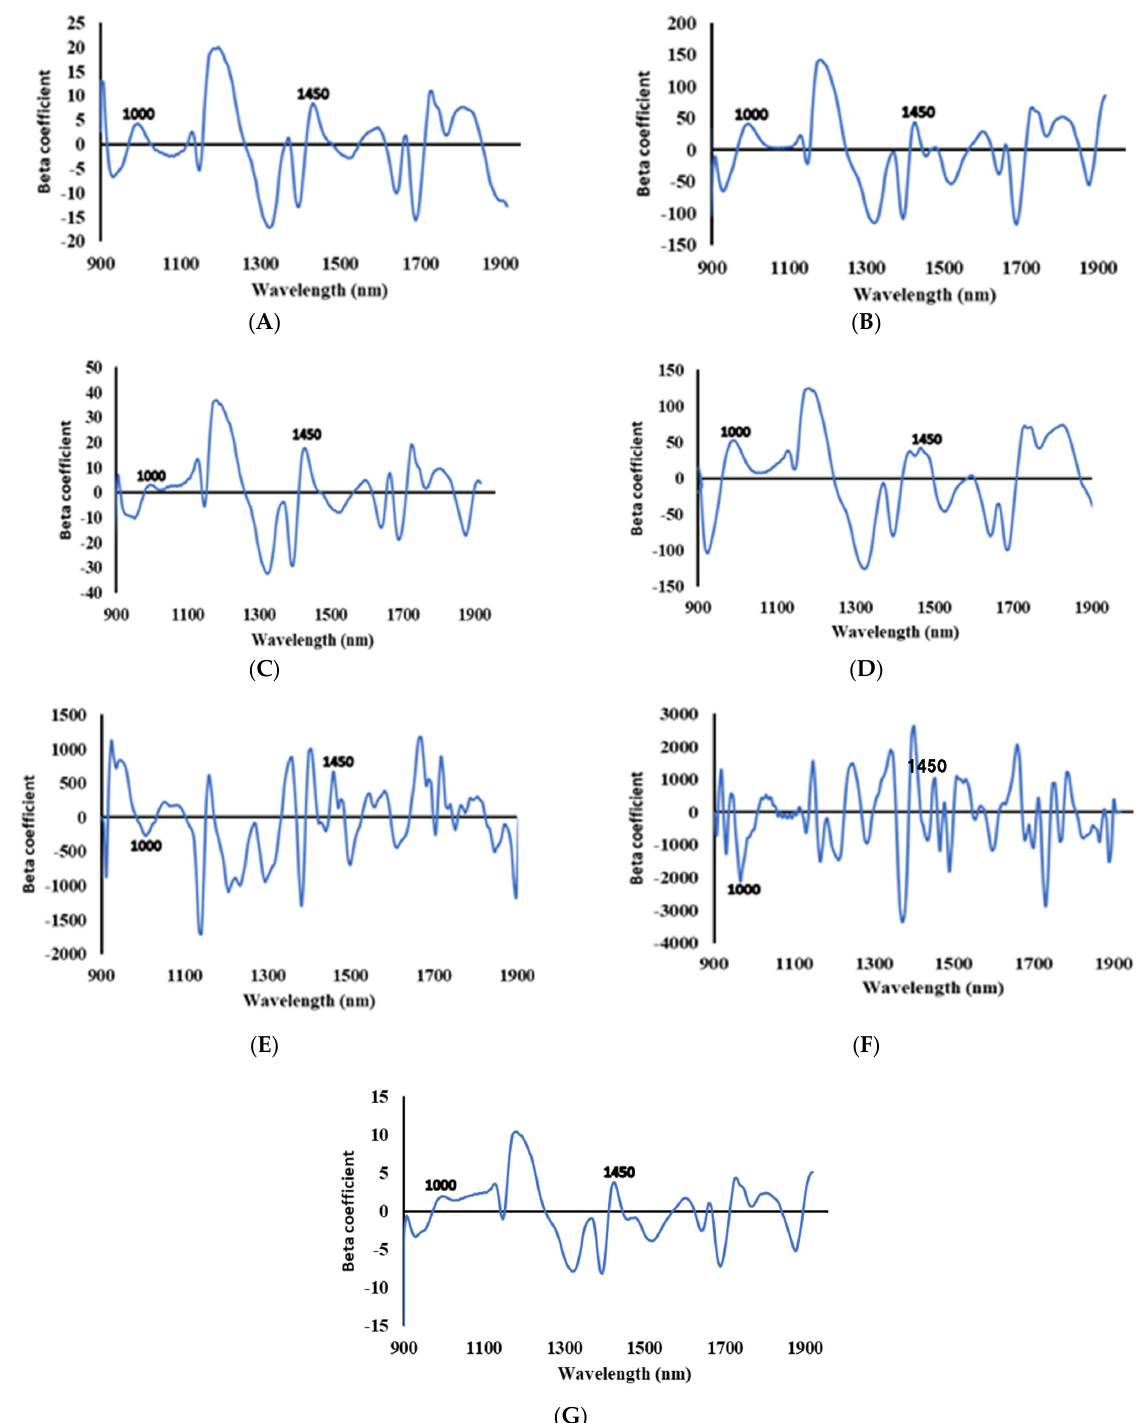
Figure 7. Beta coefficient plot: mean preprocessing ( A ); MSC preprocessing ( B ); range preprocessing ( C ); raw ( D ); Savitzky Golay 1st preprocessing ( E ); Savitzky Golay 2nd preprocessing ( F ); and SNV preprocessing ( G